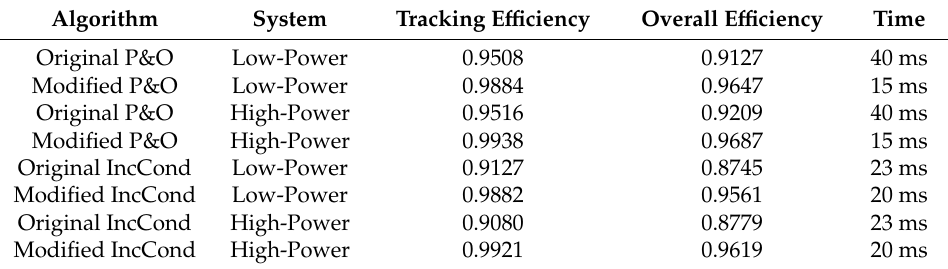
Table 5. Comparison of algorithms with low-power and high-power PV